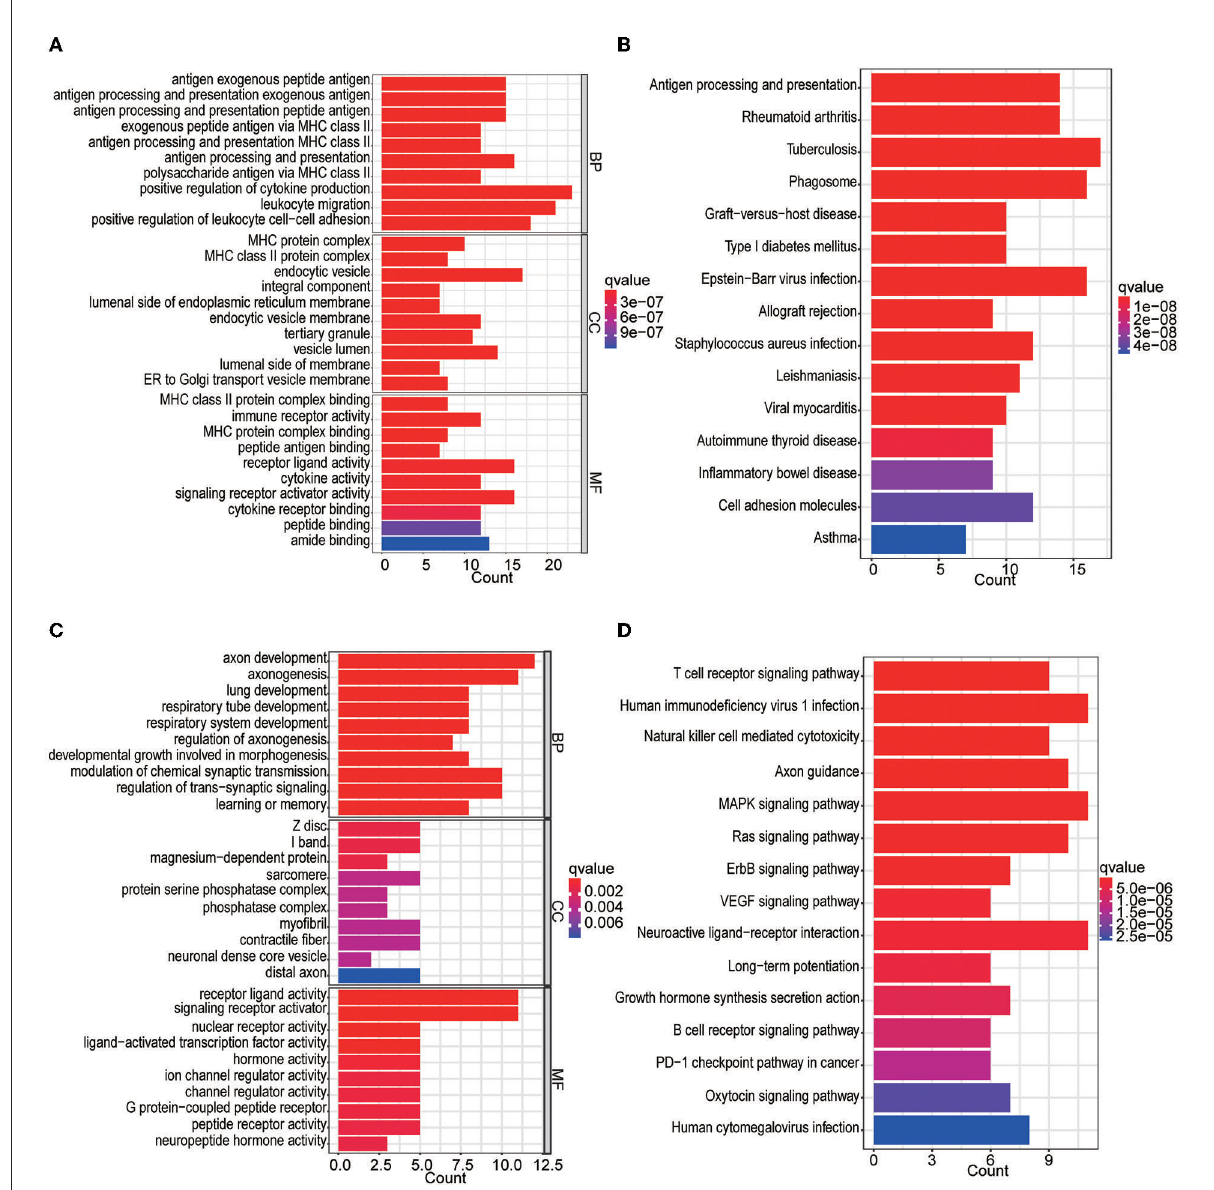
FIGURE2 GO and KEGG enrichment analyses of differentially expressed IRGs. (A) GO analysis of upregulated IRGs. (B) KEGG analysis of upregulated IRGs. (C) GO analysis of downregulated IRGs. (D) KEGG analysis of downregulated